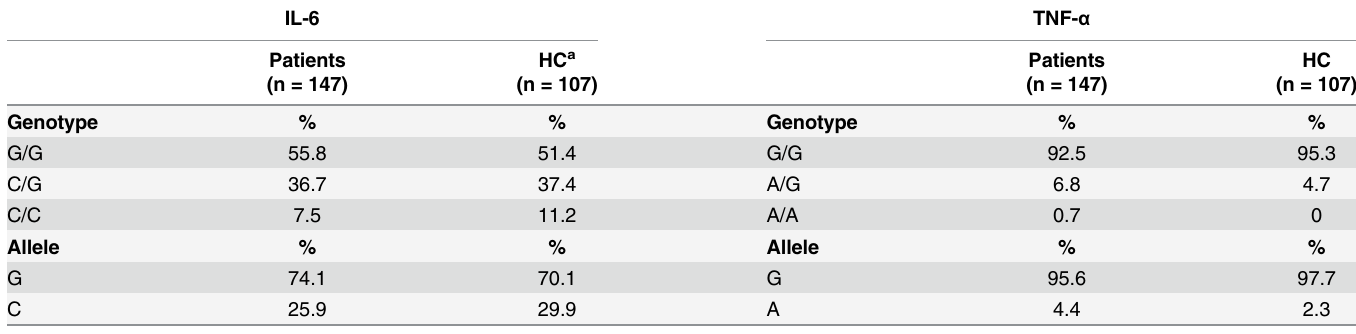
Table 2. Genotype distribution and allelic frequencies of the IL-6 – 174 G > C and TNF- α -376 G > A polymorphism in MS patients and HC.